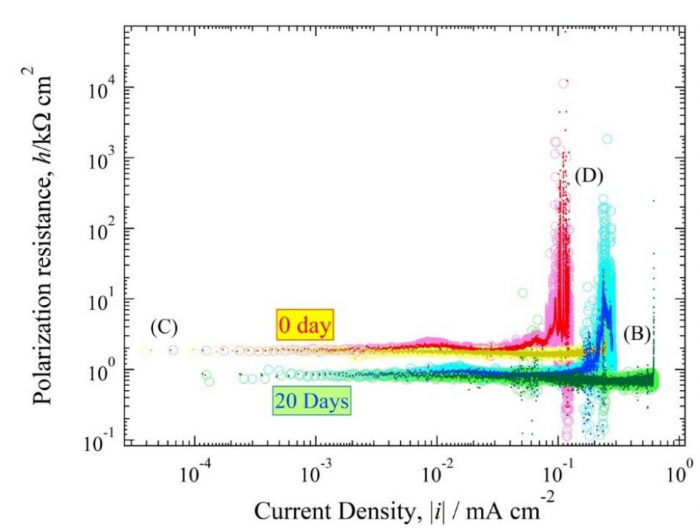
Figure 10. Polarization resistance curve of Figure 8.